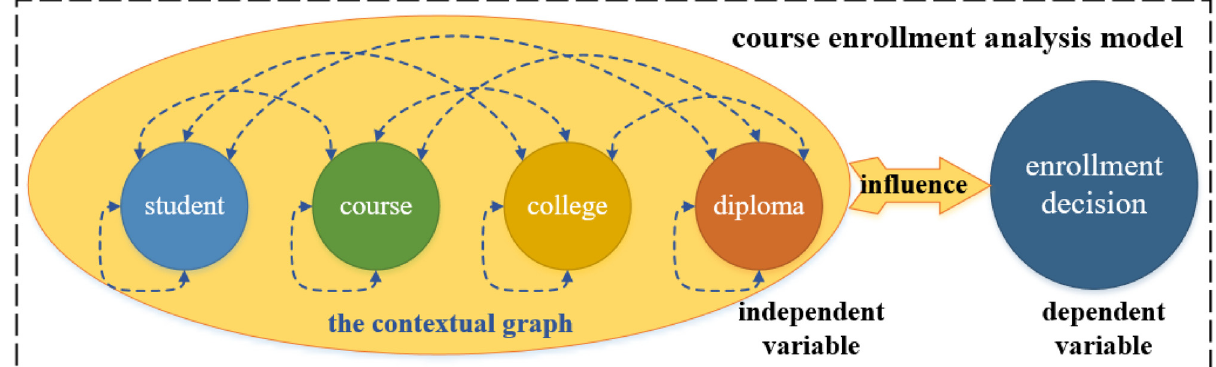
Fig 2. Illustration of the variable type transformation. The circles represent the nominalvariables, and the blue dotted lines represent the ratio variables.